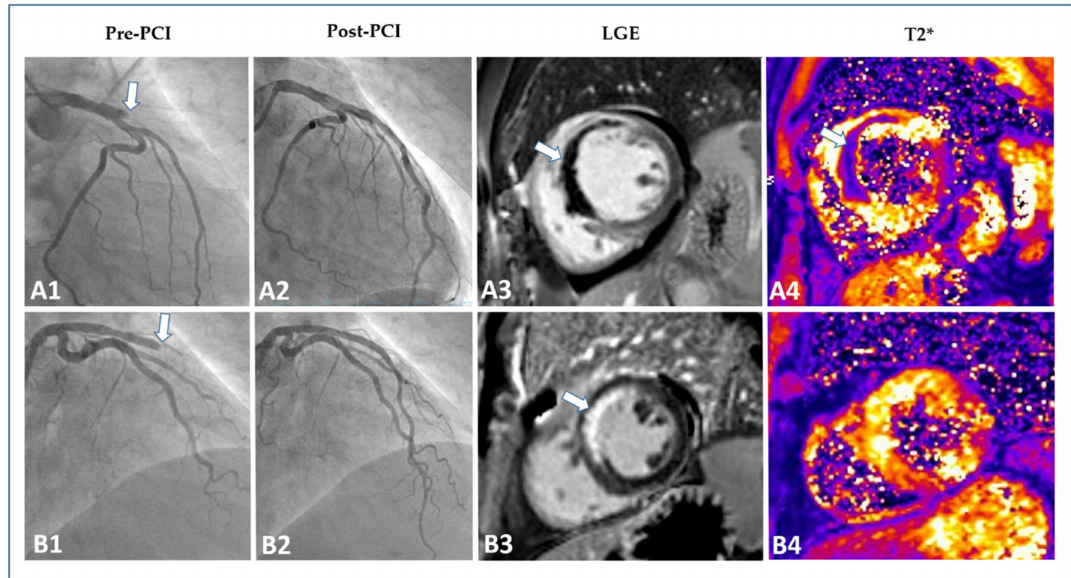
Figure 4. Evaluation of microvascular injury in STEMI. Two patient examples with anterior wall STEMI (occlusion of the left anterior descending artery). The first line ( A1 – A4 ) illustrates the pre-interventional ( A1 ) and post-interventional angiography ( A2 ) and the according CMR images (( A3 ) LGE, ( A4 ) T2*) of “Patient A”. Although successfully treated by primary PCI, “Patient A” showed a large extent of microvascular obstruction (white arrow ( A3 )) and intramyocardial hemorrhage (white arrow ( A4 )). “Patient B” (second line, ( B1 – B4 )) was also successfully treated by PCI ( B2 ). This patient, in contrast, only showed hyper-enhancement without microvascular obstruction (white arrow ( B3 )) and no evidence of intramyocardial hemorrhage ( B4 ). Abbreviations: STEMI, ST-elevation myocardial infarction; CMR, cardiac magnetic resonance; LGE, late gadolinium enhancement; PCI, percutaneous coronary